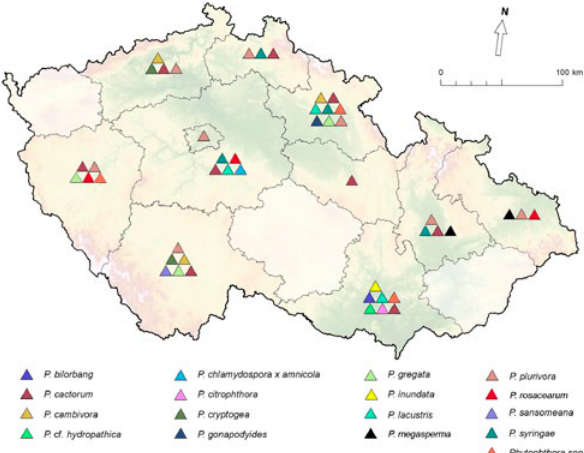
Figure 3. Regional map of the occurrence of Phytophthora spp. in fruit orchards (including irrigation water) in the Czech Republic. The regions without data are in dull colour.